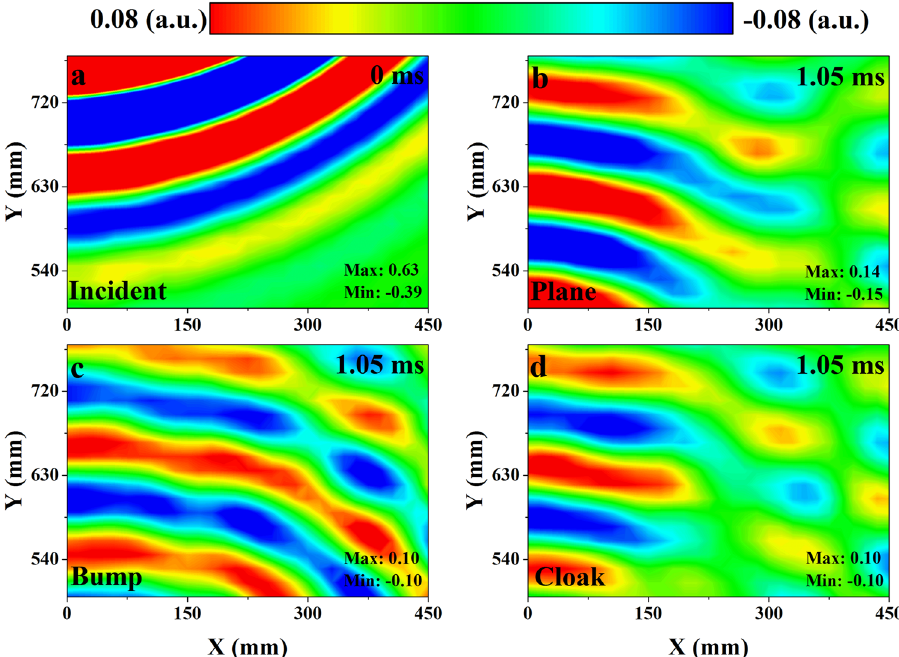
Figure 4. Measured acoustic pressure fields at 13 kHz. ( a ) The acoustic field of the incident pulse. The time of the incident acoustic field is set as 0 ms. ( b – d ) The scattered pressure fields measured after 1.05 ms. The short Gaussian pulse is reflected from the ( b ) soft plane, ( c ) soft bump and ( d ) soft bump covered by carpet cloak respectively.